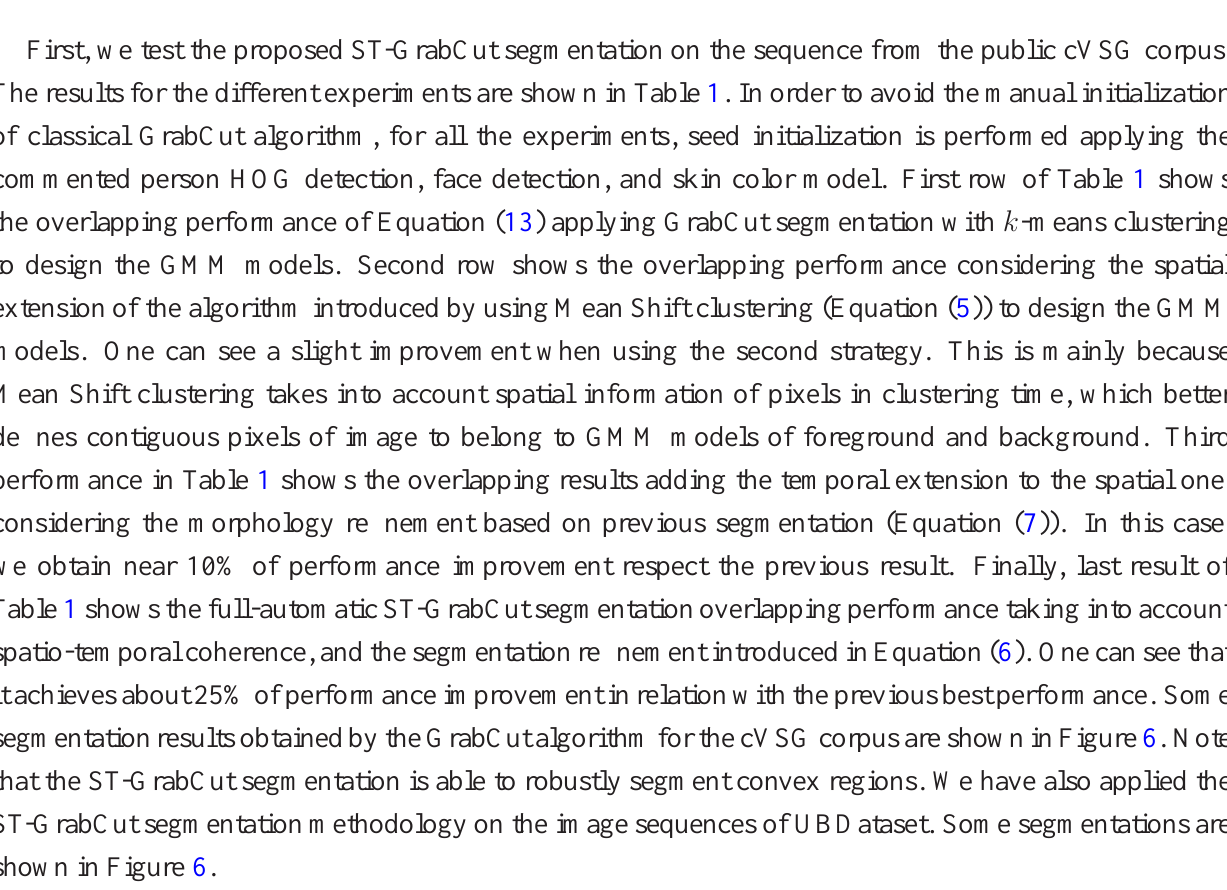
Table 1. GrabCut and ST-GrabCut Segmentation results on cVSG